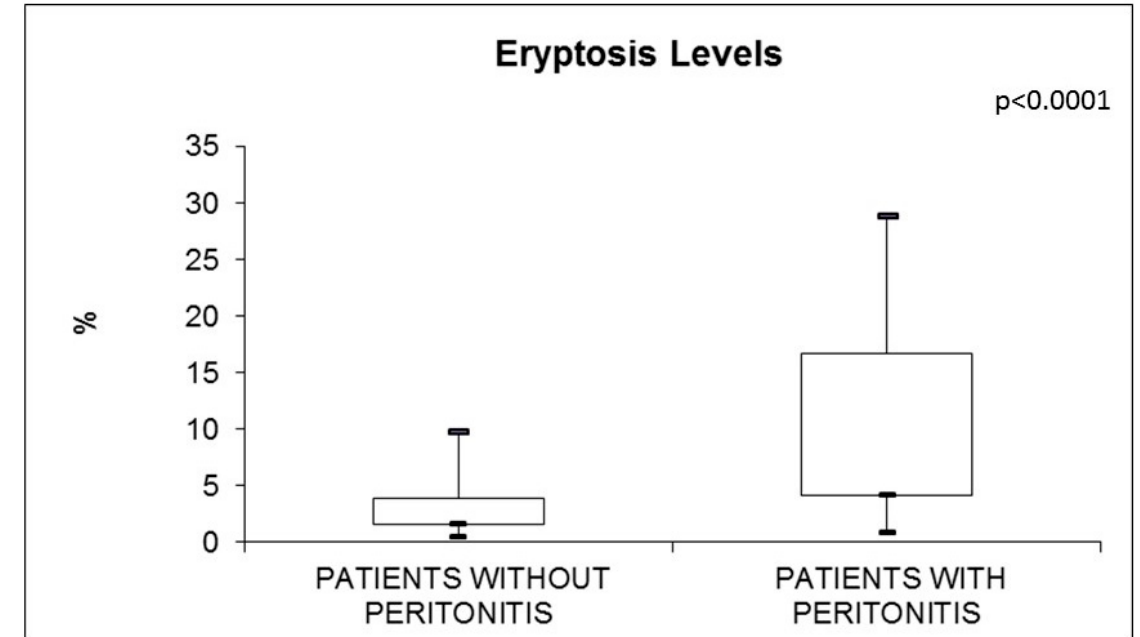
Figure 3. Eryptosis in PD subjects, with and without peritonitis.